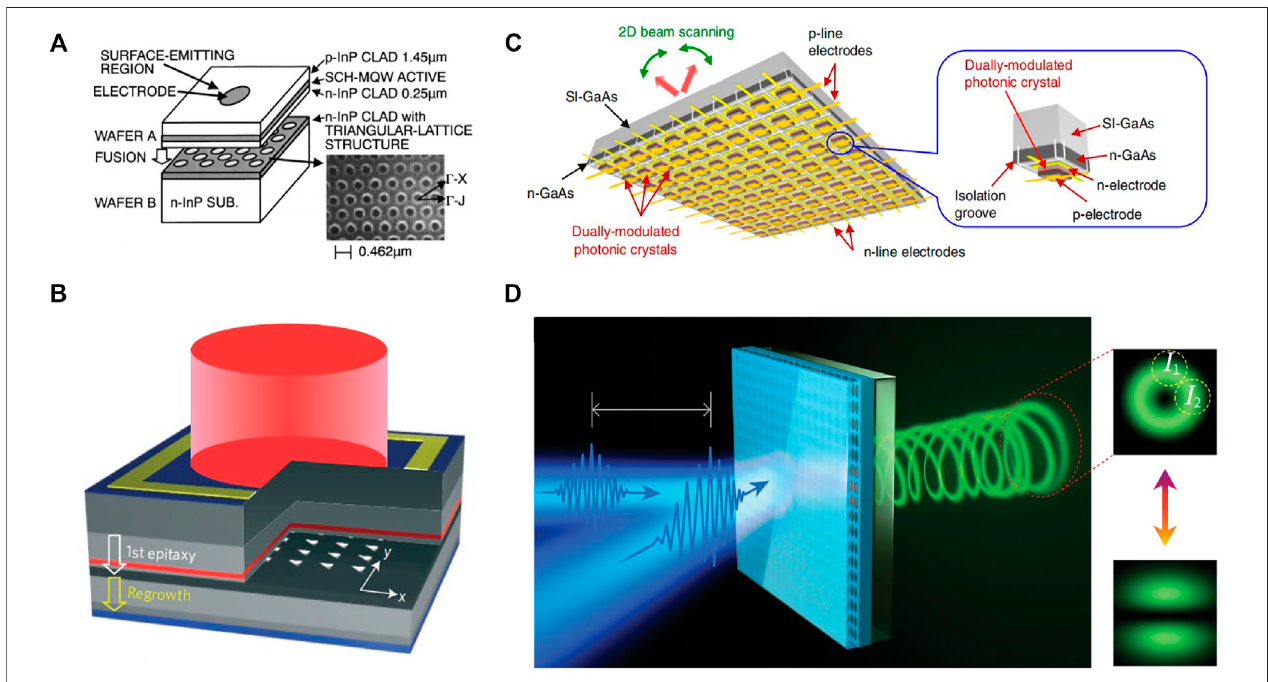
FIGURE4|(A) EarlyPCSELbasedonwaferfusiontechnique[80],copyrightAIPpublishing. (B) A W-classhigh-powerPCSEL[82],copyrightSpringerNatureLtd. (C) The on-chip beam scanning laser [123], copyright Springer Nature Ltd. (D) All-optical switching from the vortex microlaser [124], copyright AAAS.